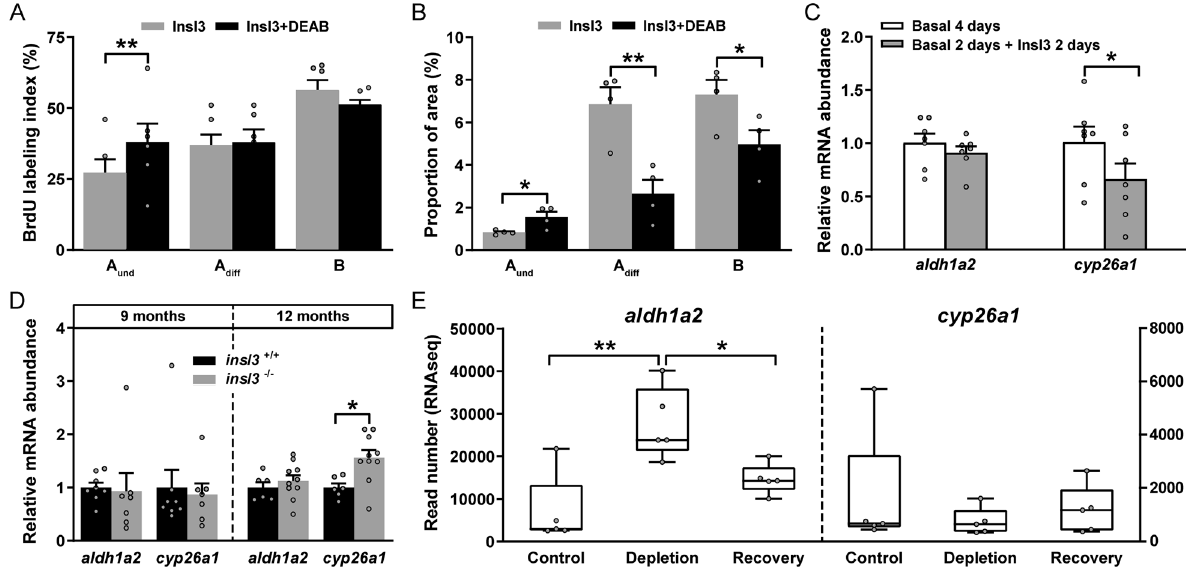
Fig. 5 Involvement of retinoic acid (RA) signaling in Insl3-induced spermatogenesis. A , B Evaluation of the proliferation activity ( A ) and of the proportions of spermatogonia ( B ) in zebra fi sh testes cultured for 4 days with 100 ng/mL Insl3, and in the absence or presence of the RA inhibitor DEAB (10 μ M). C Ex vivo transcript levels of the RA producing ( aldh1a2 ) and degrading enzymes ( cyp26a1 ) in testis tissue incubated in the absence or presence of 100 ng/mL Insl3. D aldh1a2 and cyp26a1 expression levels in wild-type ( insl3 + / + ) and insl3 knockout ( insl3 − / − ) testes 9 and 12 months post-fertilization. E Read numbers (RNAseq) of RA metabolic enzymes in control, germ cell-depleted (by exposure to the cytostatic agent busulfan 51 ), and testes with recovering (from busulfan) spermatogenesis, as described by Crespo et al. 25 (NCBI GEO data set GSE116611). In A , B and E , data are shown as mean ± SEM ( A : N = 6; B : N = 4; E : N = 5; * p < 0.05; ** p < 0.01), and in C , D as mean fold change ± SEM ( C : N = 7; D : insl3 + / + and insl3 − / − 9 months, N = 8 and 7; insl3 + / + and insl3 − / − 12 months, N = 6 and 10; * p < 0.05) and expressed relative to the control group (which is set at 1). A und , type A undifferentiated spermatogonia; A diff , type A differentiating spermatogonia; B, type B